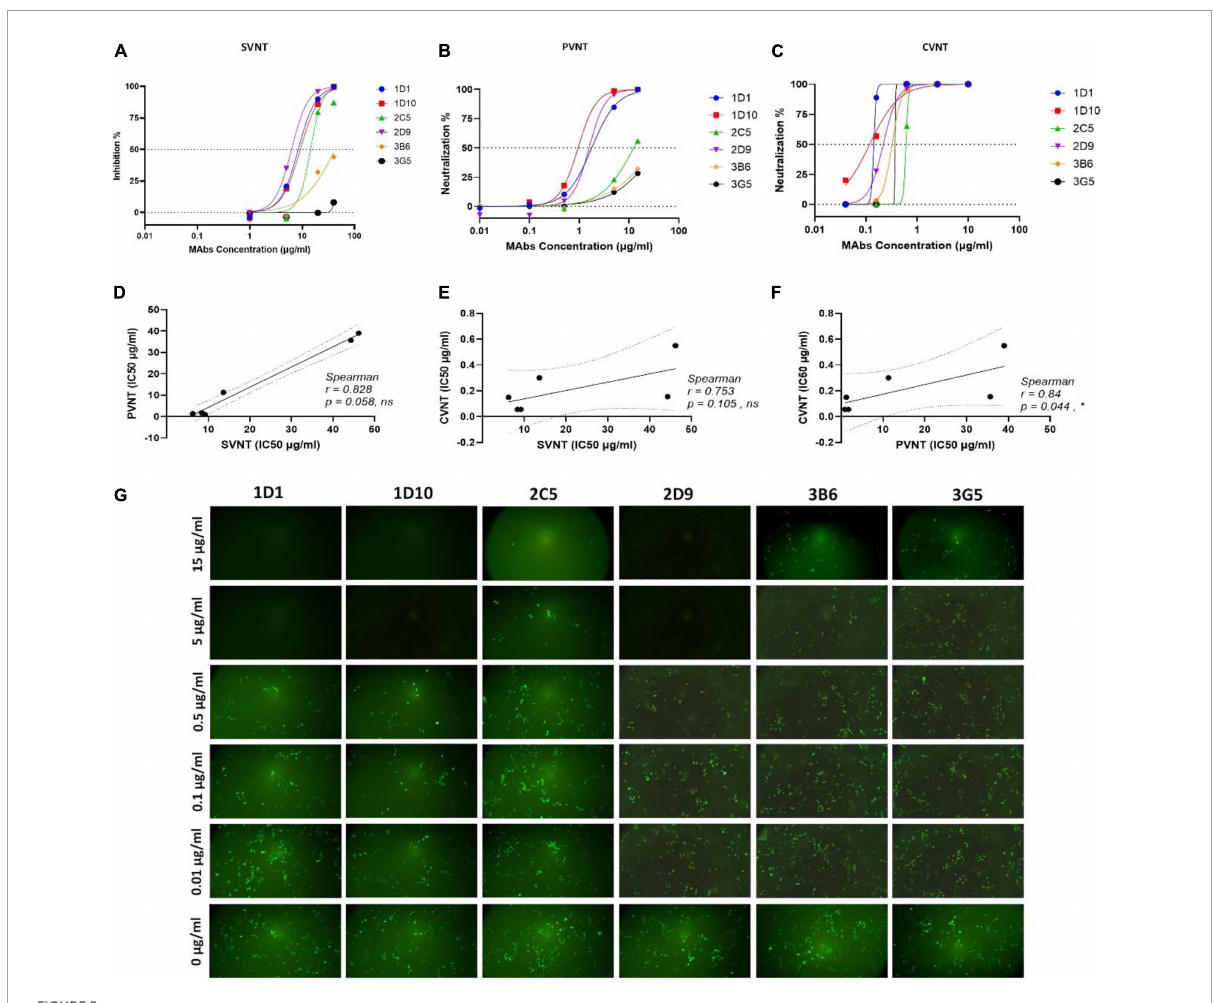
FIGURE5 Neutralizing activity of MAbs was determined by PVNT, SVNT, and CVNT. (A) Selected RBD-specific MAbs were assessed for neutralization by SVNT. HRP-conjugated ACE2 protein was used to determine its binding to immobilized RBD in the presence of MAbs at the concentrations of 1, 5, 20, and 40 µ g/ml. The percentage (%) of inhibition was calculated based on the OD of HRP-conjugated ACE2 with or without presence of RBD-specific MAbs. Dose-response curves are presented for each MAb. The IC50 value was calculated by non-linear regression (four-parameter), as represented in Table 2 . (B) Dose-response curves of selected MAbs determined by PVNT. Five different concentrations of selected MAbs, 0.01, 0.1, 0.5, 5, and 15 µ g/ml, were incubated with pseudovirus and added to HEK293T-hACE2 cells (14 × 10 3 cells/well). ImageJ software was used to calculate the fluorescence positive cells 60 h post-infection to calculate IC50 values and the inhibition ratios. The IC50 was calculated by non-linear regression (four-parameter), as represented in Table 2 . (C) Representative dose-response curves of selected MAbs determined by CVNT. The selected MAbs were diluted to different concentrations, incubated with the WT D614G SARS-CoV-2 to reach the final concentrations of 0.04, 0.16, 0.63, 2.5, and 10 µ g/ml, and added to Vero 76 cells. The percentage of infected cells was calculated by counting nucleocapsid positive cells versus total cells. The IC50 was calculated by non-linear regression (four-parameter), as represented in Table 2 . The dotted lines on each graph indicate 0 and 50% neutralization. (D–F) The correlation of obtained IC50 values between SVNT, PVNT, and CVNT was calculated by Spearman analysis. (G) Representative fluorescence images of HEK293T cells expressing hACE2 after infection with eGFP-pseudotyped lentiviruses in the absence or presence of different concentrations of anti-RBD MAbs. ACE2, angiotensin-converting enzyme-2; CVNT, conventional virus-neutralizing test; HRP, horse-radish peroxidase; IC50, inhibition concentration 50%; MAb, monoclonal antibody; OD, optical density; PVNT, pseudovirus neutralization test; RBD, receptor binding domain; SARS-CoV-2, severe acute respiratory syndrome coronavirus 2; SVNT, surrogate virus-neutralizing